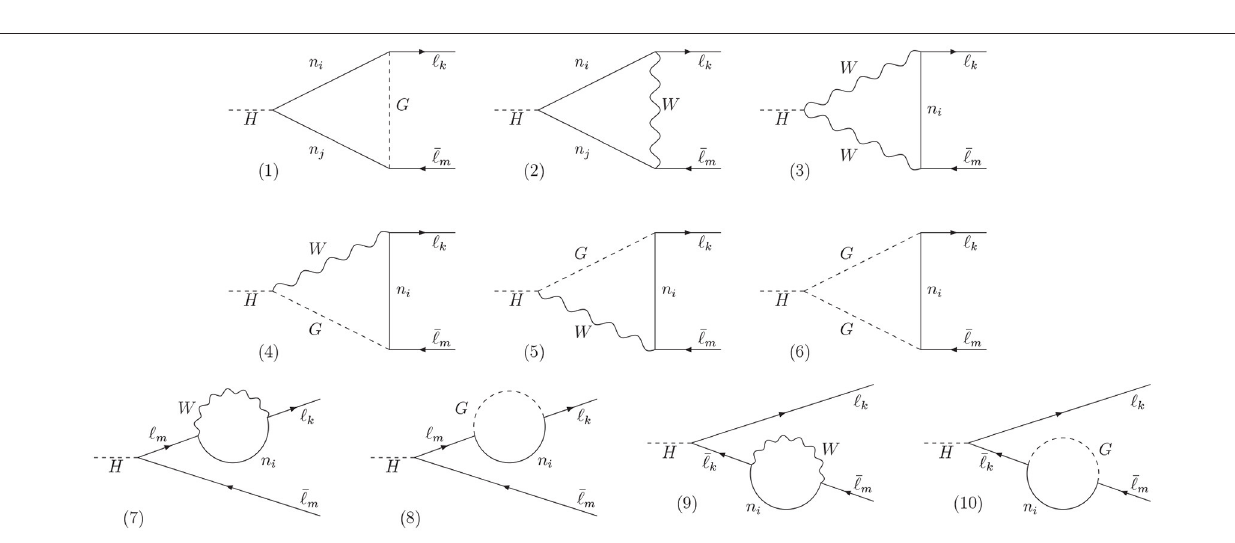
mass terms, or equivalently the Yukawa couplings. Thus, each